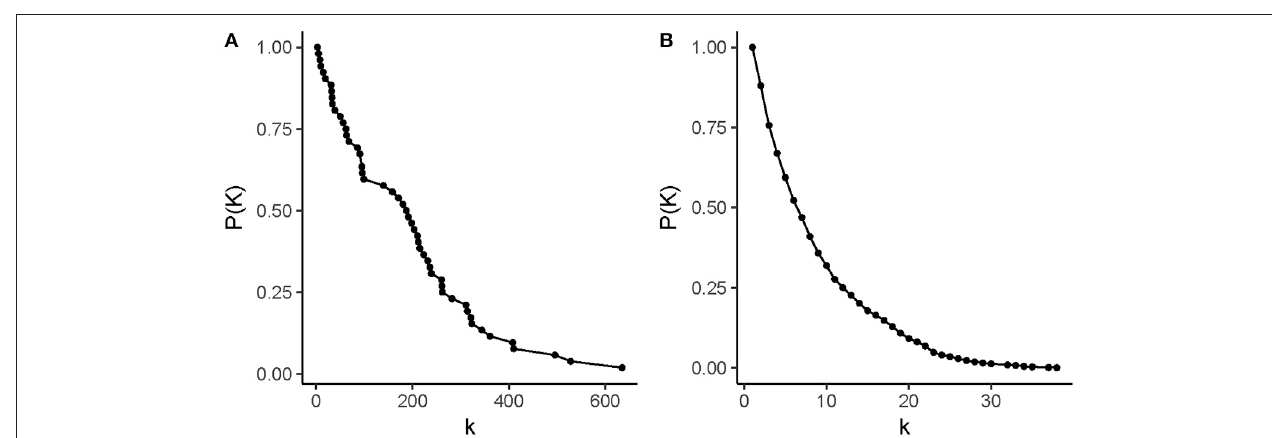
FIGURE 5 | Degree distributions in drug-adverse drug reaction (ADR) networks. This figure illustrates the degree distribution of (A) drug nodes and (B) ADR nodes. In each panel, the normalized, complementary cumulative degree frequency distribution is presented. Drug nodes have degree values that range from 0 to 635, while pathways have degree values that range from 1 to